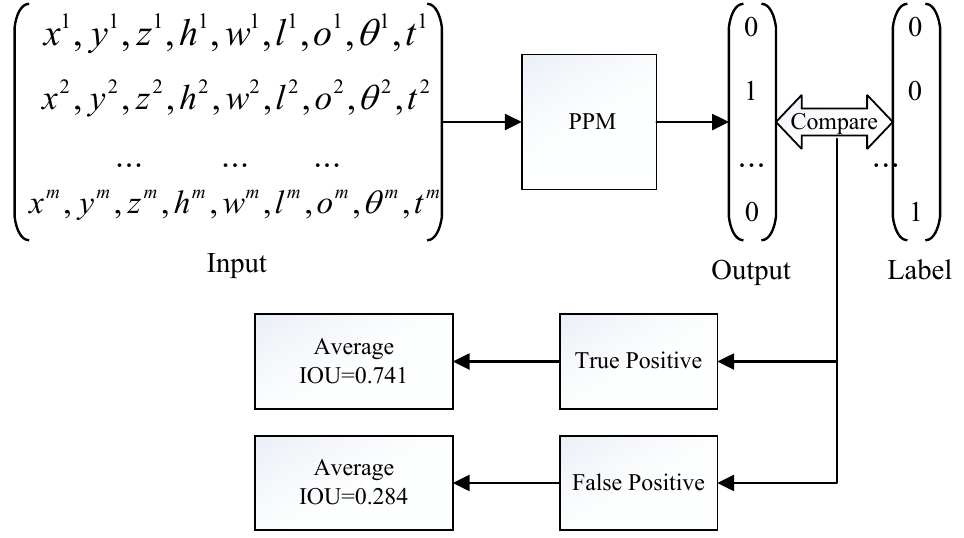
Figure 11. The process of evaluation. Since the negative samples have no IOU value, only the IOU of positive samples are